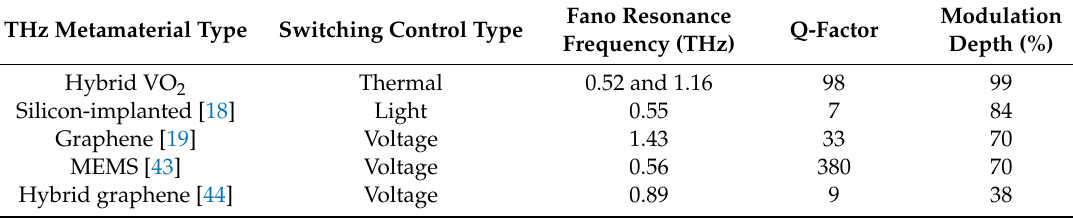
Table 1. The comparison between the predicted performance with others previously